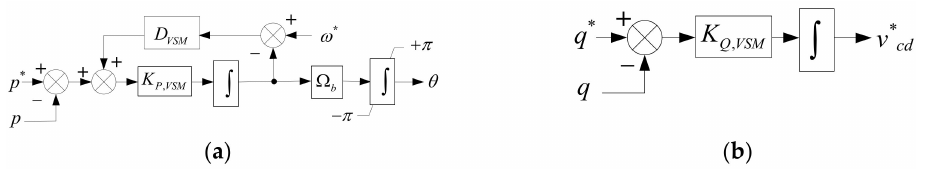
Figure 8. Control of active ( a ) and reactive ( b ) power in the implemented